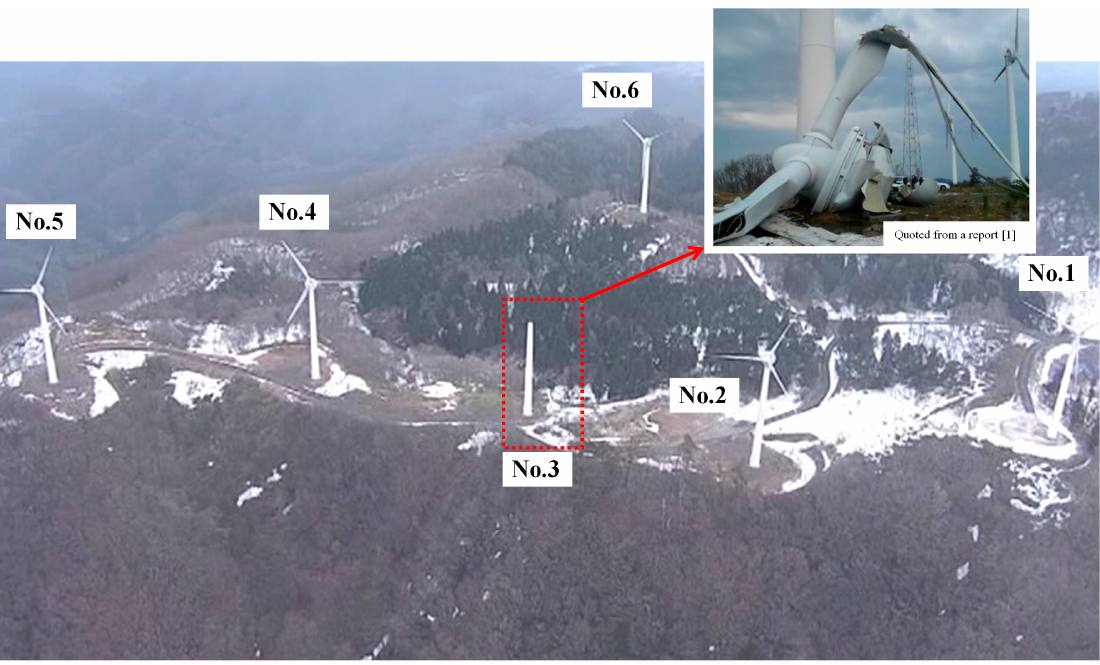
Figure 2. Still image of wind turbine accident, taken from a video by RKB Mainichi Broadcasting Corporation.